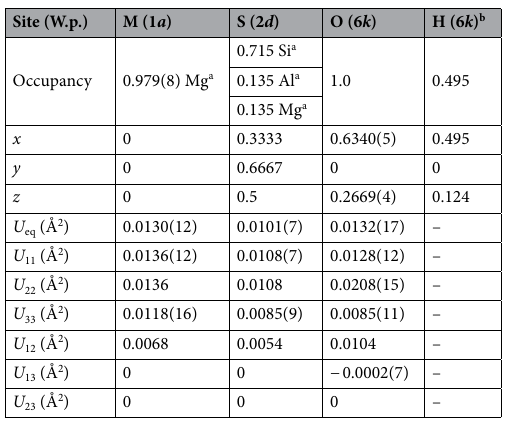
Table 3. Refined structural parameters. W.p. Wyckoff position. a Site occupancy parameters of Si and Al were fixed on S-site, and those of Mg were constrained between M- and S-sites to keep the chemical composition from the electron probe microanalyses. b H-atom position was determined from the difference Fourier synthesis, and not